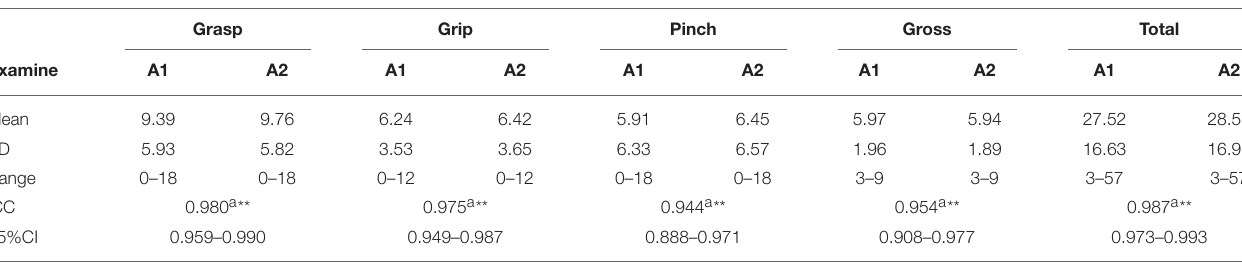
TABLE 3 | C-ARAT intra-rater